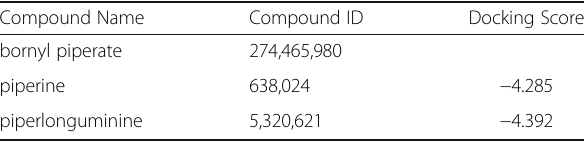
Table 5 Docking result of bornyl piperate, piperine and piperlonguminine with COX-2 (PDB: